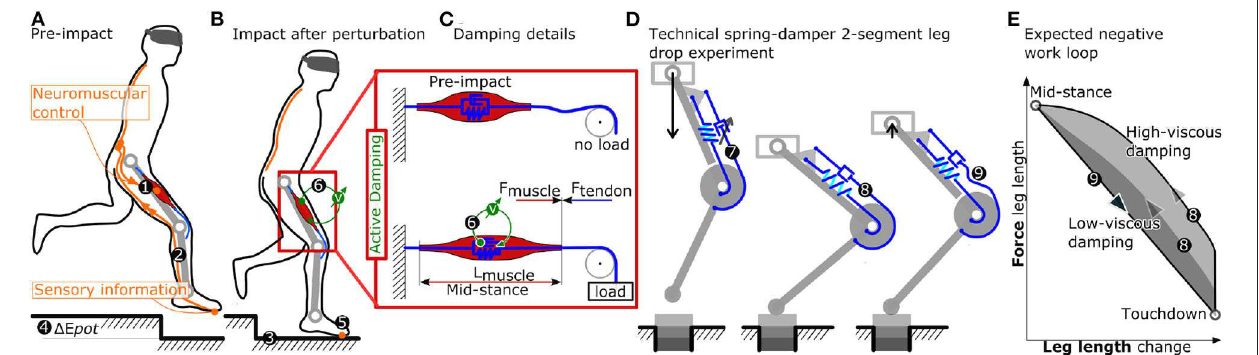
FIGURE 1 | (A–C) Problem identification, and related research question. The limited nerve conduction velocity in organic tissue (More et al., 2010) 2 presents a significant hazard in legged locomotion. Local neuromuscular strategies 6 provide an alternative means of timely and tunable force and power production. Actuators like the indicated knee extensor muscle keep the leg extended during stance phase (muscle length L muscle ) by producing the appropriate amount of muscle force (F muscle ), correctly timed. Neuromuscular control 1 plays a major role in initiating and producing these active muscle forces, but works best only during unperturbed locomotion. Sensor information from foot contact travels via nerves bundles 2 to the spinal cord, but with significant time delays in the range of t = 40ms (More and Donelan, 2018, for 1m leg length) and more. Hence, the locomotion control system can become “sensor blind” due to conduction delays, for half a stance phase, and can miss unexpected perturbations like the depicted step-down. During step-down perturbations 3 additional energy 4 is inserted into the system. Viscous damper-like mechanisms produce velocity dependent counter-forces, and can dissipate kinetic energy. Local neuromuscular strategies 6 producing tunable, viscous damping forces would act instantaneously and adaptively. Such strategies 6 could also be robust to uncontrolled and harsh impacts of the foot after perturbations 5 , better than sensor-based strategies. In this work (D) , we are testing and characterizing spring-damper configurations mounted to a two-segment leg structure, during rapid- and slow-drop experiments, for their feasibility to physically and instantaneously produce tunable, speed-dependent forces extending the leg. Work loops (E) will indicate how much effective negative work is dissipated, between touch-down and mid-stance. Prior to impact 7 and during the leg loading 8 the spring-damper’s tendons act equally. Starting at mid-stance, the main spring extends the knee, leading to leg extension and leaving the damper’s tendon slack 9